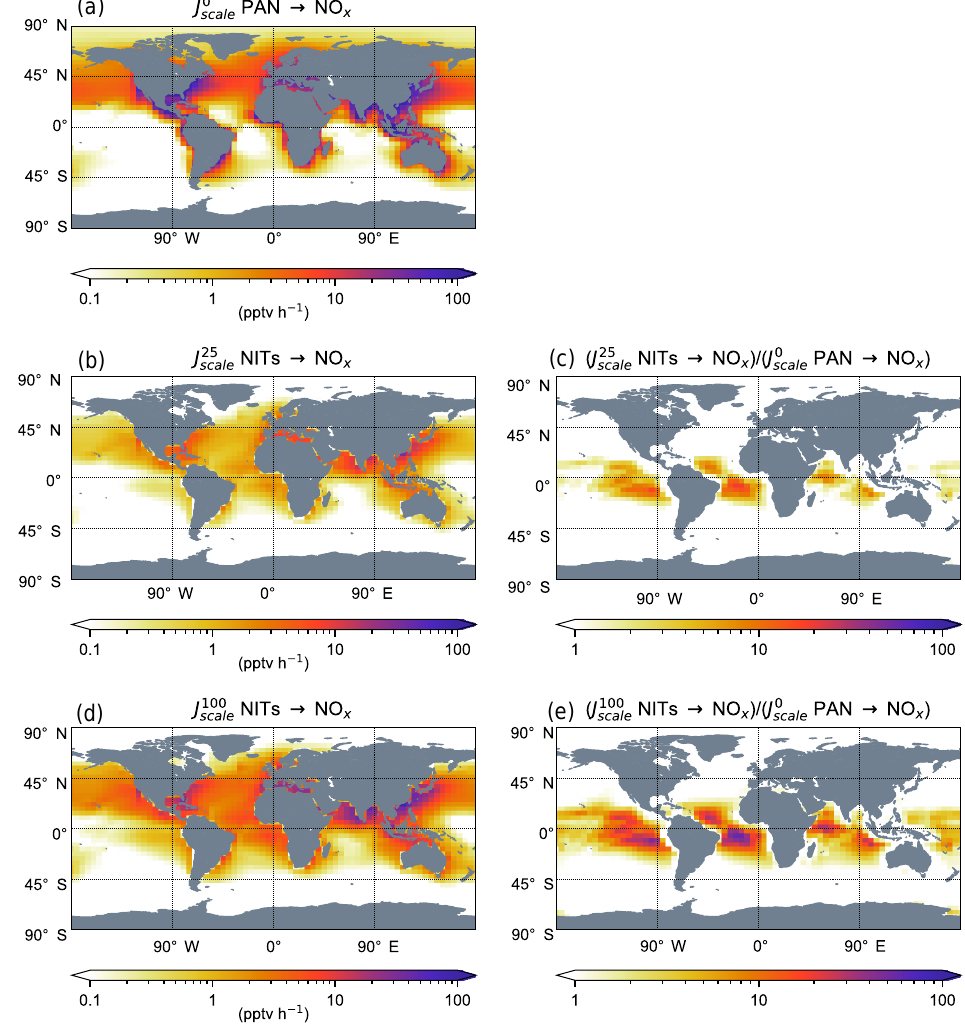
Figure 8. Simulated 2014–2015 MBL-average (average over bottom 1km) NO x production rate from PAN decomposition for the J 0 (b) and J 100 (d) model runs. The ratio of the NO x production rate from NITs model run (a) and from NITs photolysis for the J 25 scale scale and J 100 model runs relative to the NO x production rate from PAN decomposition for the J 0 photolysis for the J 25 scale scale shown in panels (c) and (e) ,